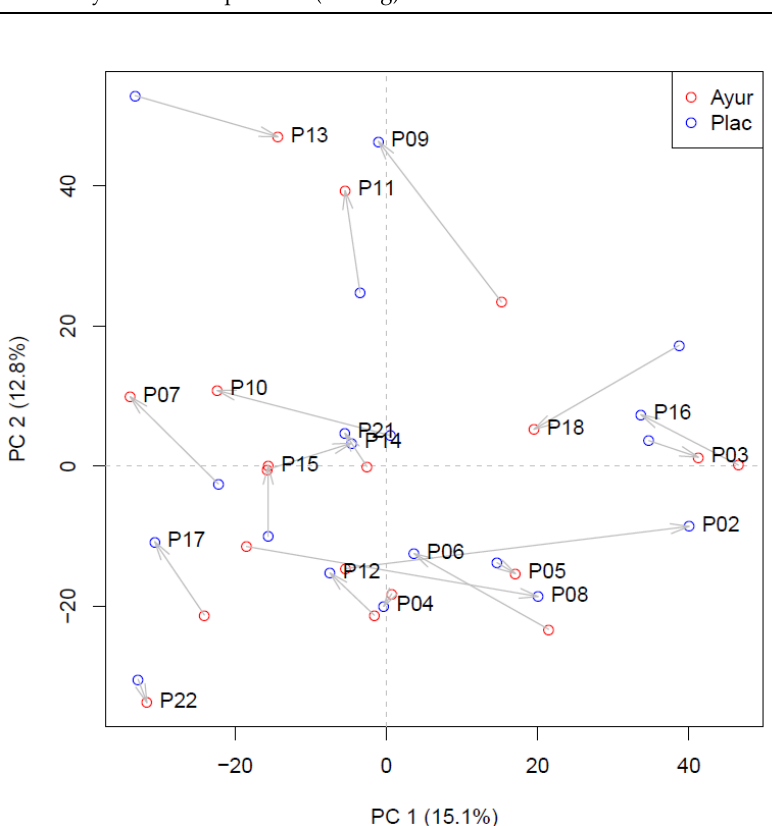
Figure 2. Principal Component Analysis (PCA) score plot of the urine metabolomic data of the subjects. Red symbols indicate treatment, blue symbols indicate placebo. The arrows connect the two symbols for individual subjects, and are pointing from the results of the first stage to the results of the second stage.